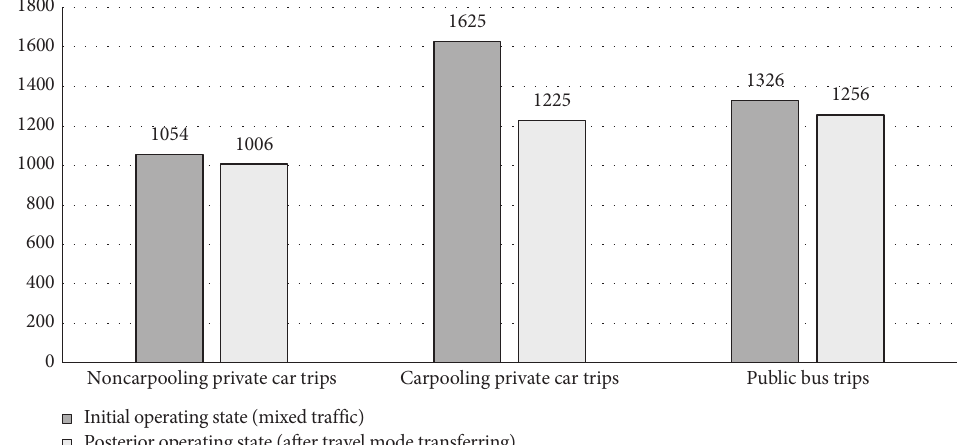
Figure 9: Comparison of travel time before and after implementing HOV lanes priority dynamic control for different travel modes.